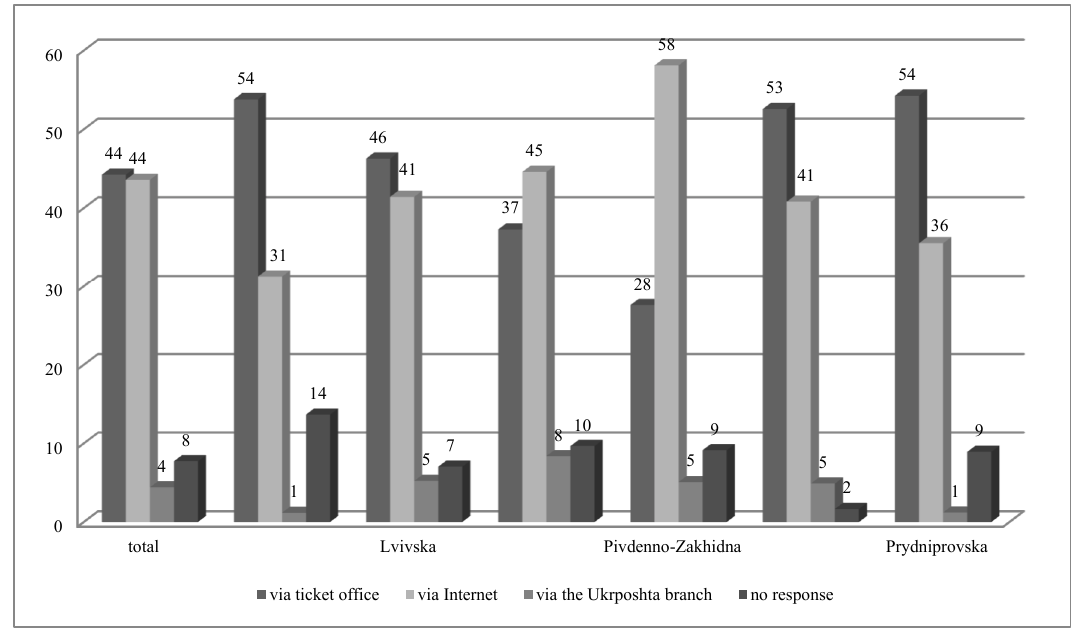
Figure 4. Distribution (%) of the preferences of respondents in the method used for booking and payment of travel documents in total and per separate railway.